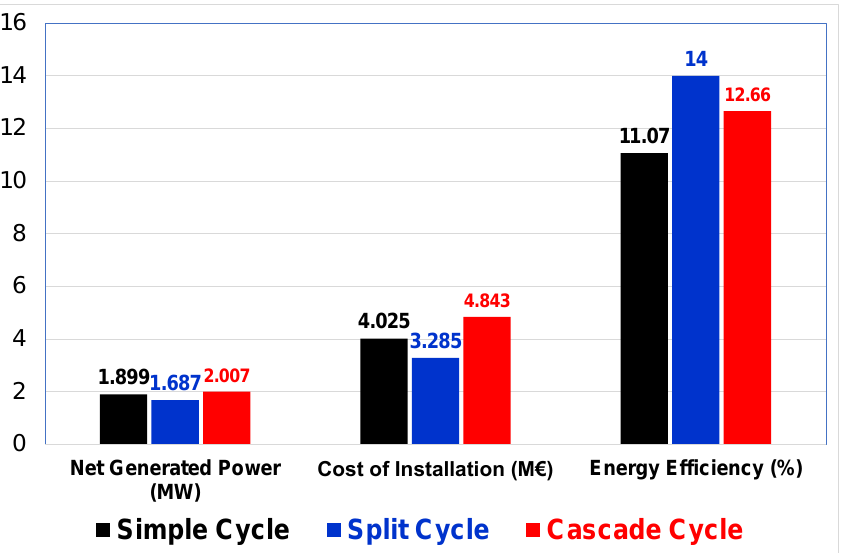
Figure 9. Theoretical results for the net generated power, the installation cost, and the thermal efficiency of the simple supercritical CO 2 cycle, the split supercritical CO 2 cycle, and the cascade supercritical CO 2 cycle.